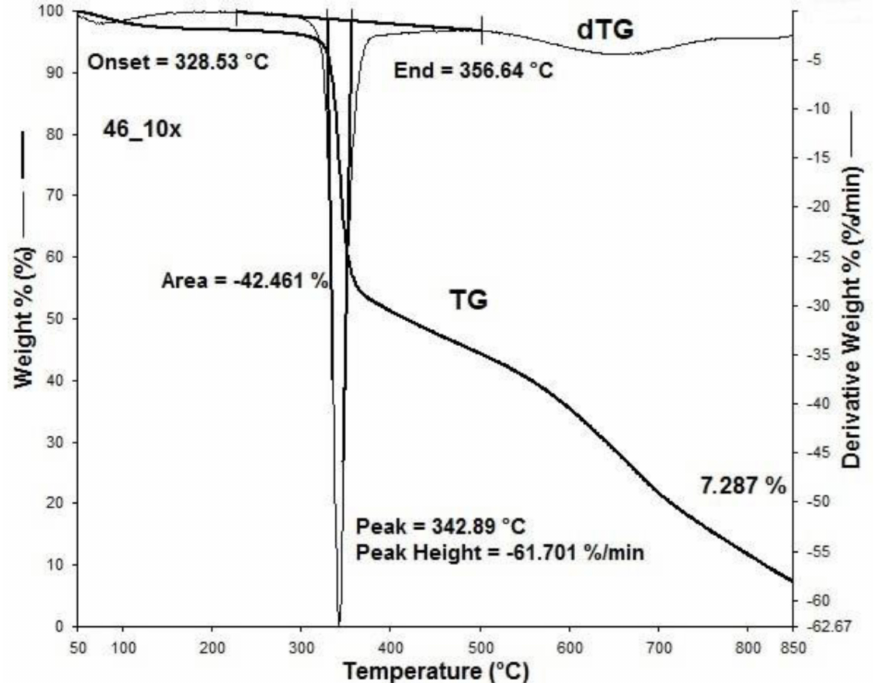
Figure 3. Thermogravimetric analysis of 46_10x sample: TG curve, dTG